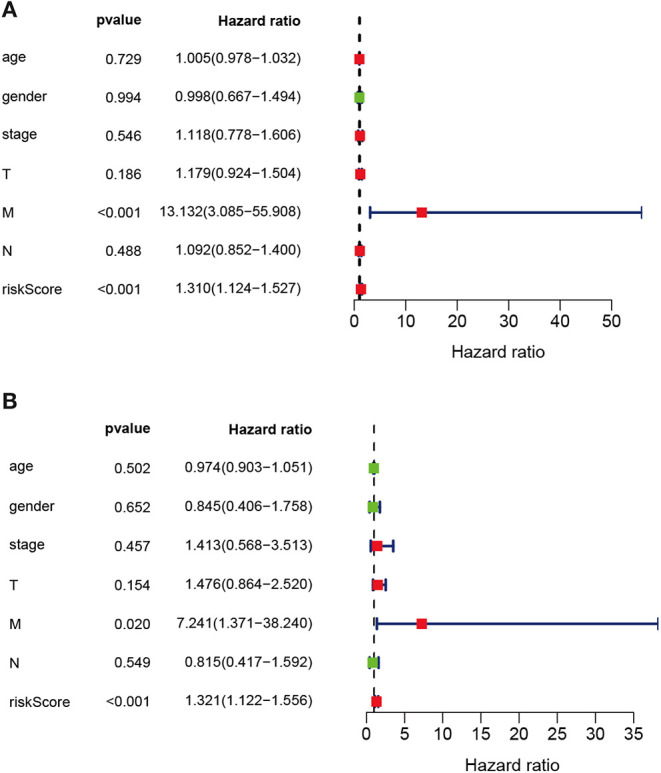
Univariate and multivariate independent prognostic analysis in LUSC. (A) Univariate independent prognostic analysis forest map of the prognostic immune-related genes model and LUSC clinicopathological characteristics. (B) Multivariate independent prognostic analysis forest map of prognostic immune-related genes model and LUSC clinicopathological characteristics. The red dots in the forest map shows that the clinical characteristic is a high-risk factor. The green dots in the forest map shows that the clinical characteristic is a low-risk factor.